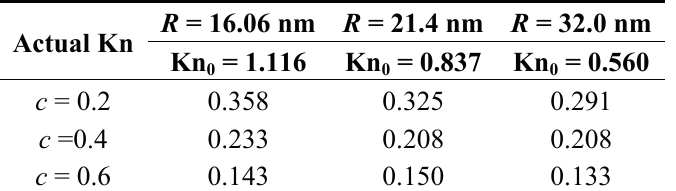
Table 2. Comparison between the Kn gas mean free path and the actual Knudsen